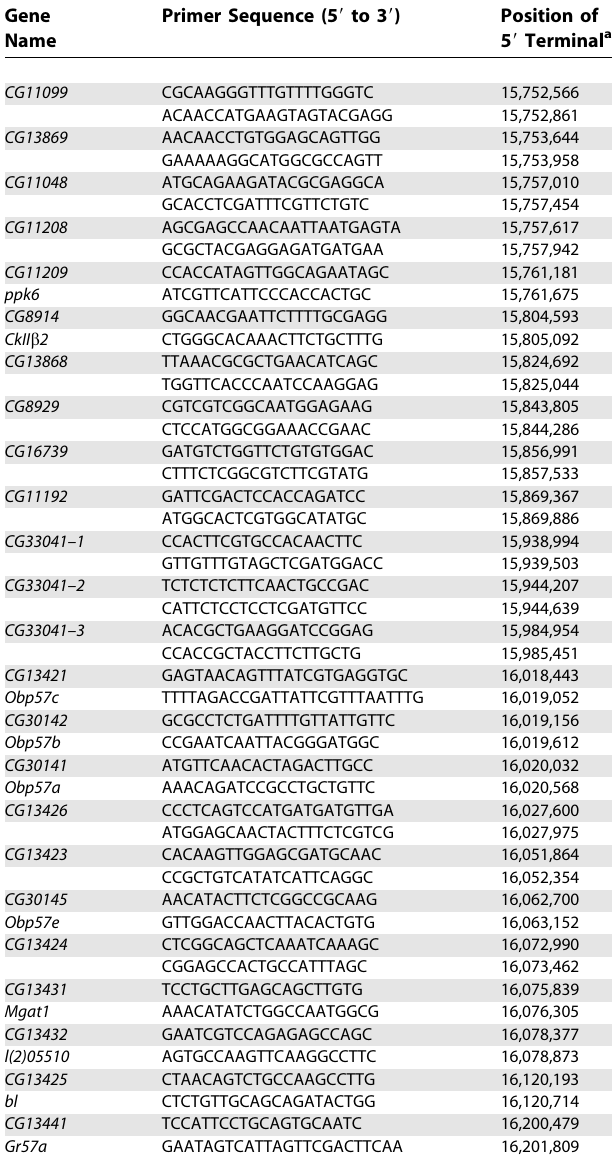
Table 5. Primer Sequences Used for Determination of